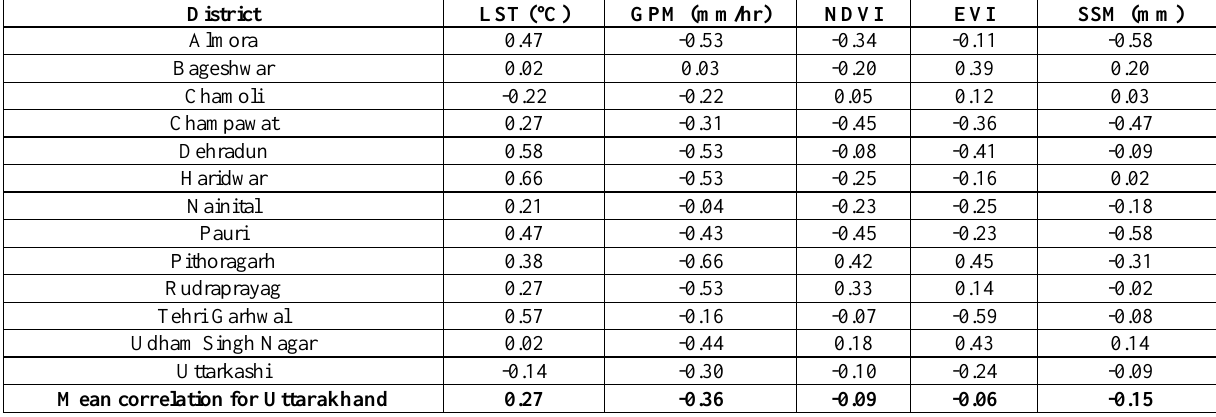
Table 2. Correlation coefficient values for all the districts and mean for Uttarakhand